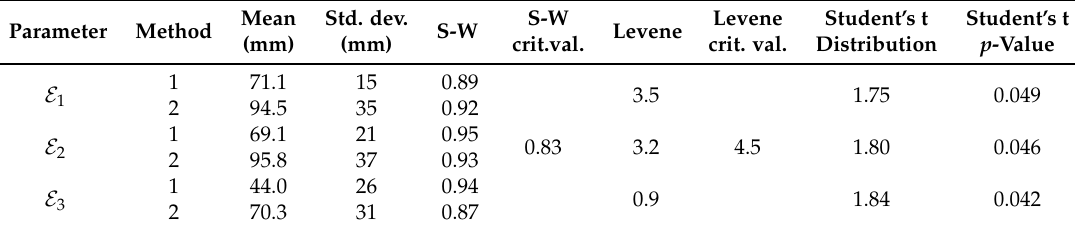
Table 4. Results of the Shapiro–Wilk (S-W) test, Levene’s test, and Student’s t -test for the parameters E E E 2 , and 3 and the two learning methods. 1 , Std. Parameter